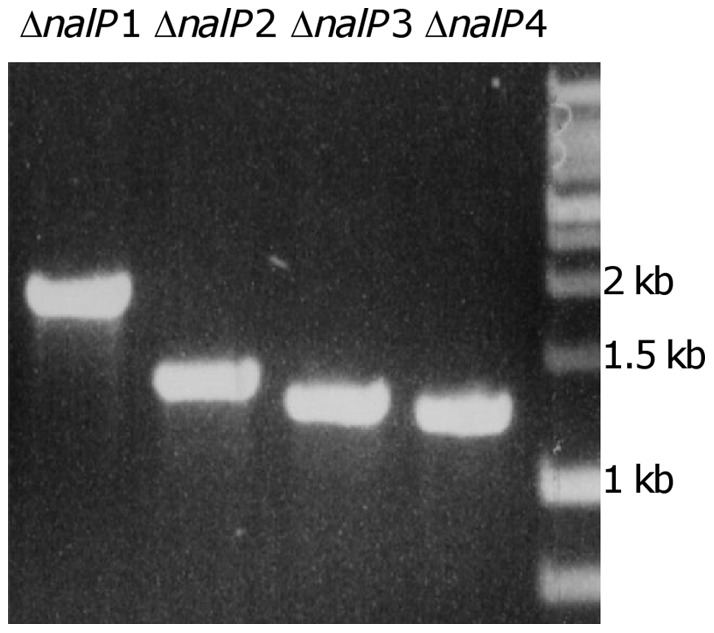
Variations in the size of the nalP deletion locus amongst N. meningitidis carriage isolates.The nalP deletion loci were amplified with primers specific for flanking genes. Amplicons were grouped into four classes based on size; representative samples are shown. ΔnalP1 (V128; Dec), ΔnalP2 (V130; Nov), ΔnalP3 (V199; Nov) and ΔnalP4 (V206; Dec).